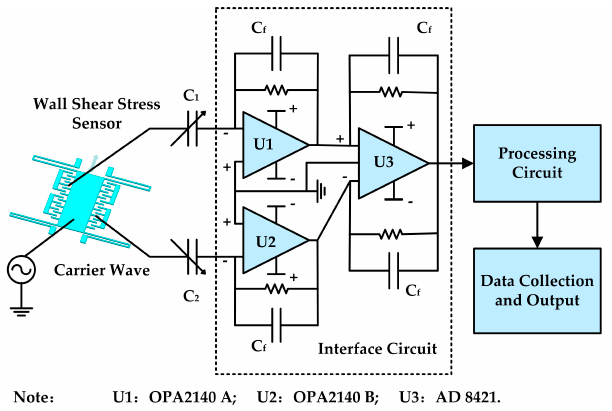
Figure 4. Interface circuit of the floating element wall shear stress sensor.